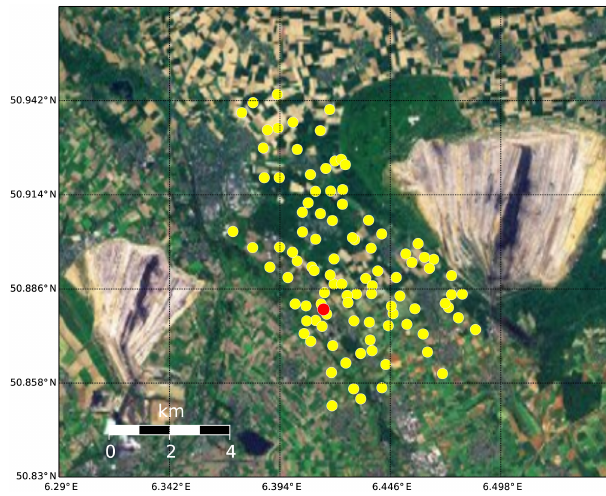
Figure 1. Experimental setup: distribution of pyranometers (yel- low), sky imager (red) and ceilometer (red) at the measurement site. Map section corresponds to the chosen domain size of 20km × 20km.